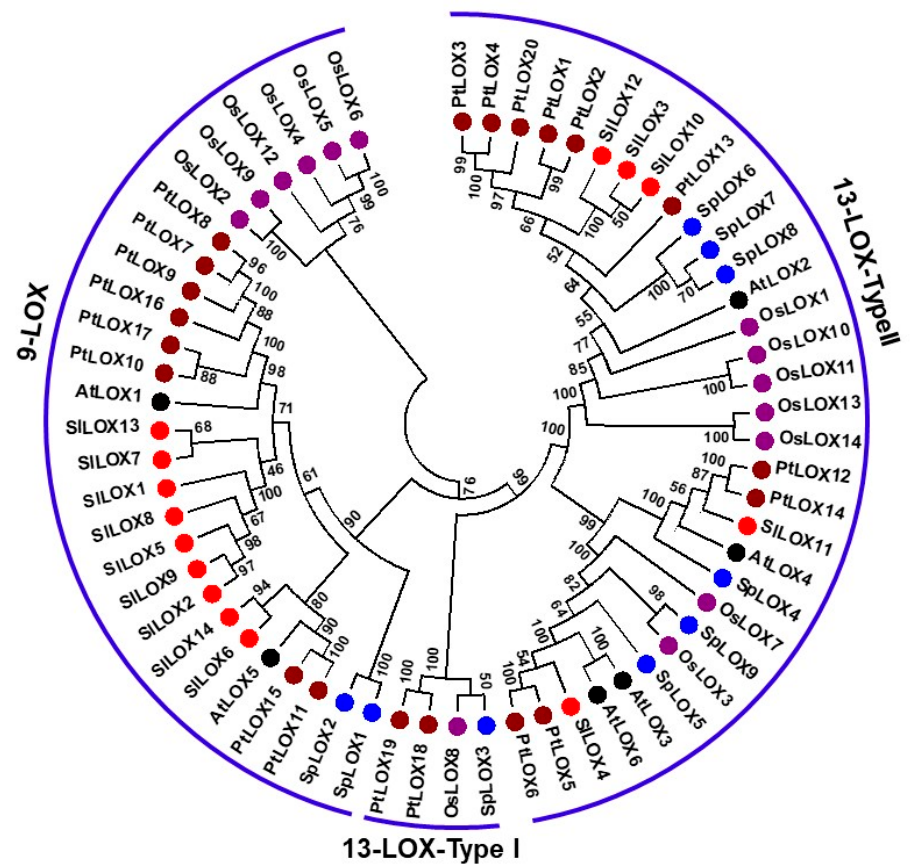
Figure 1. Molecular phylogenetic relationships of the Spirodela polyrhiza lipoxygenase (LOX) family with LOX gene families from additional plants. The evolutionary history was inferred using the maximum likelihood method based on the JTT matrix-based model. The bootstrap consensus tree inferred from 1000 replicates is taken to represent the evolutionary history of the taxa analyze. The analysis involved 63 amino acid sequences from five di ff erent plants: duckweed (Sp), tomato (Sl), Arabidopsis (At), rice (Os), and poplar (Pt). All positions with less than 95% site coverage were eliminated. Evolutionary analyses were conducted in MEGA7. The bootstrap values of the confidence levels are shown as percentages at branch nodes. The LOX gene family of each species is color coded. LOXs of di ff erent species fall into two separate groups: 9-LOX and 13-LOX. The 13-LOX group was further subdivided into type I and type II. Phylogenetic analysis assigned seven LOX proteins from Spirodela to the 13-LOX group and two LOX proteins to the 9-LOX group.